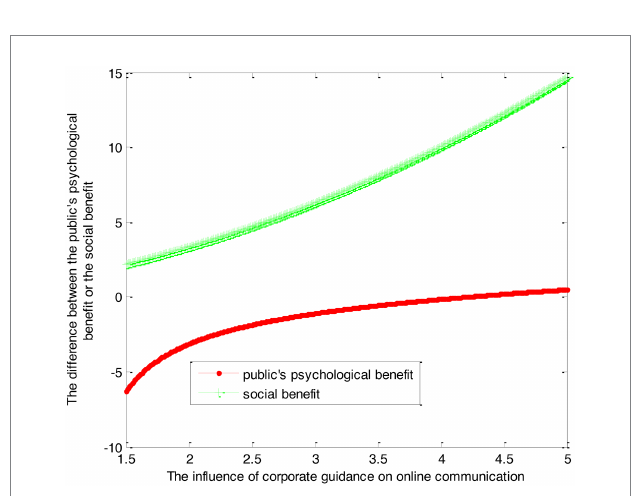
FIGURE 3 The difference between self-guidance and social force